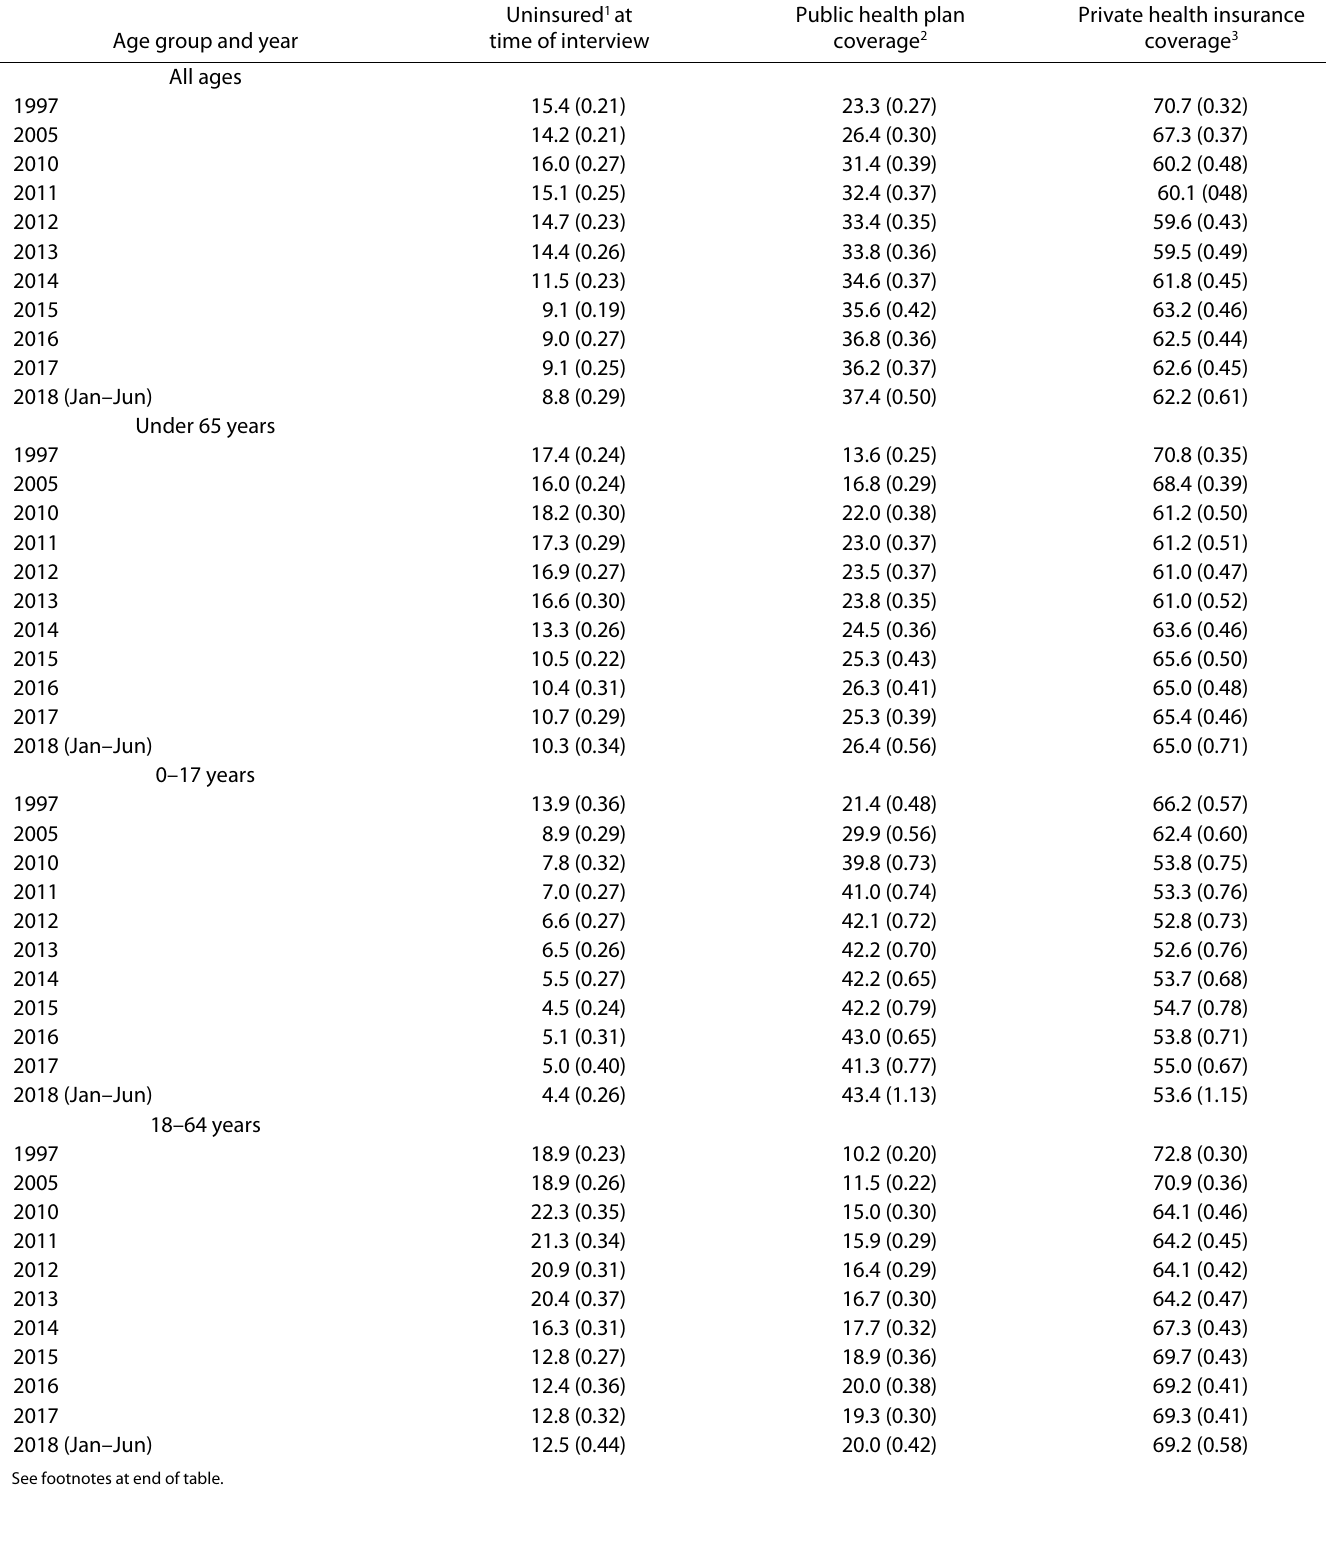
Table III. Percentages (and standard errors) of persons who lacked health insurance coverage, had public health plan coverage,